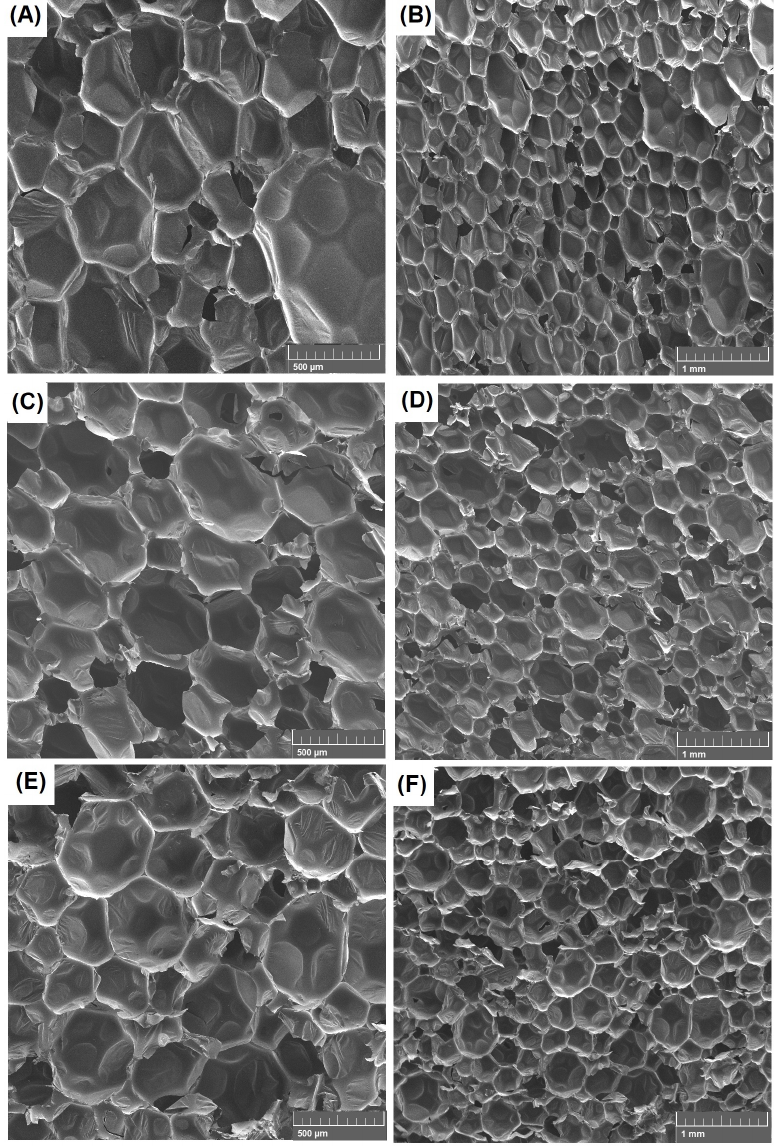
Figure 11. SEM photos: reference sample ( A , B ), foam + coffee grounds 10 wt.% ( C , D ) and foam + sawdust 10 wt.% ( E , F ) on a scale 500 µ m and 1